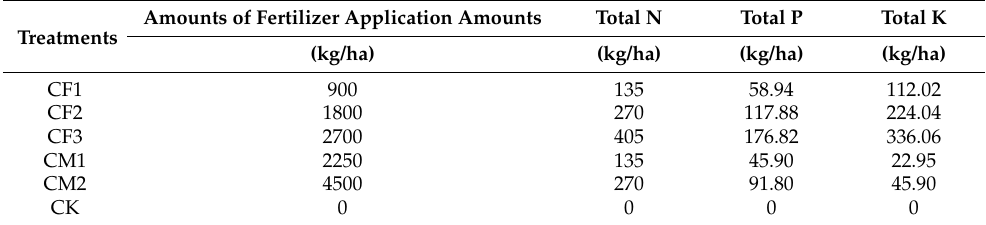
Table 1. Fertilizer applications for the different treatments of the field experiment in the western suburb of Shanghai, Southeast